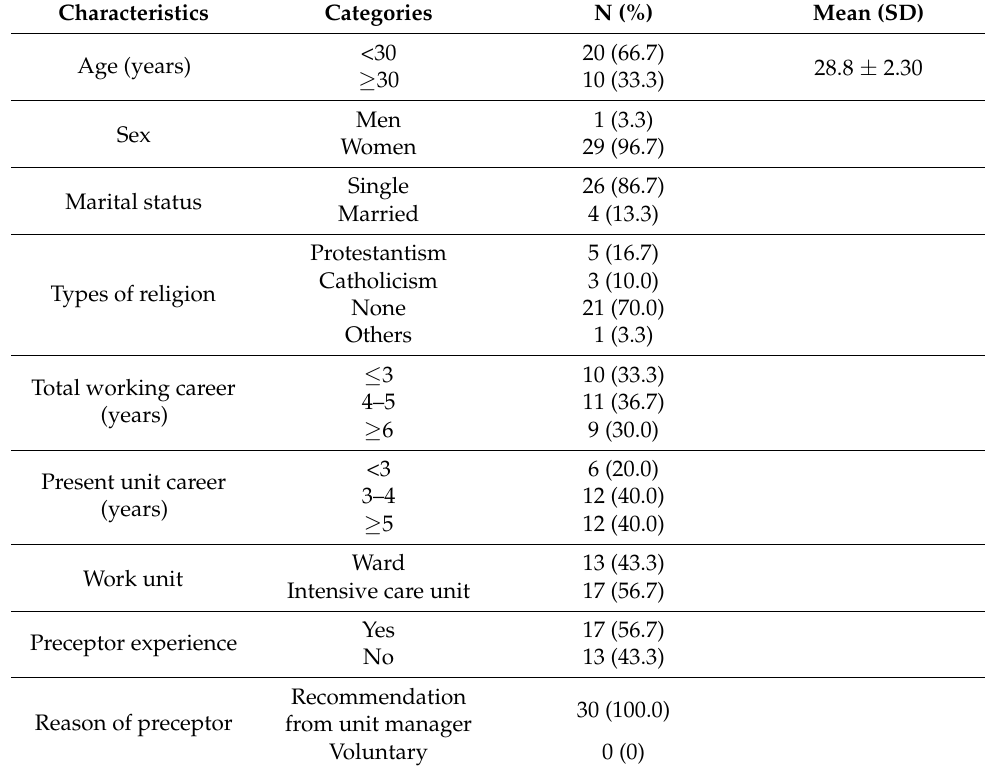
Table 1. Participants’ General Characteristics.